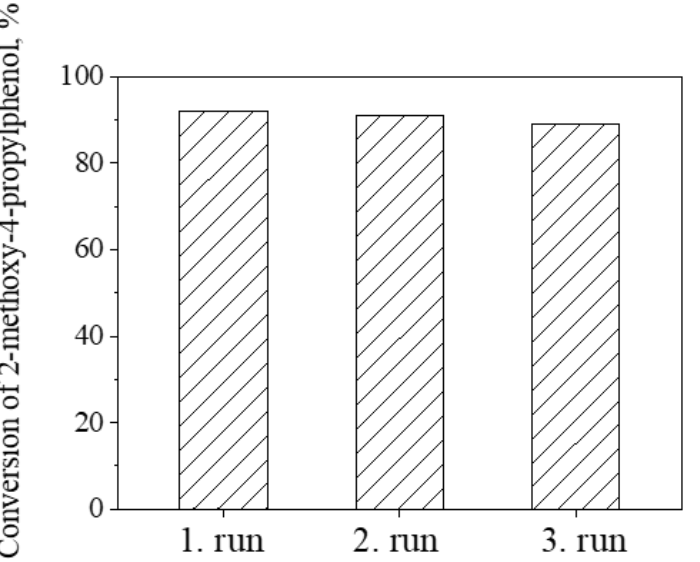
Figure 10. Catalytic activity of 5Ru1Pt-modified Beta zeolites in hydrodemethoxylation and dealkylation of 2-methoxy4-propylphenol at 300 °C in 3 reaction cycles.